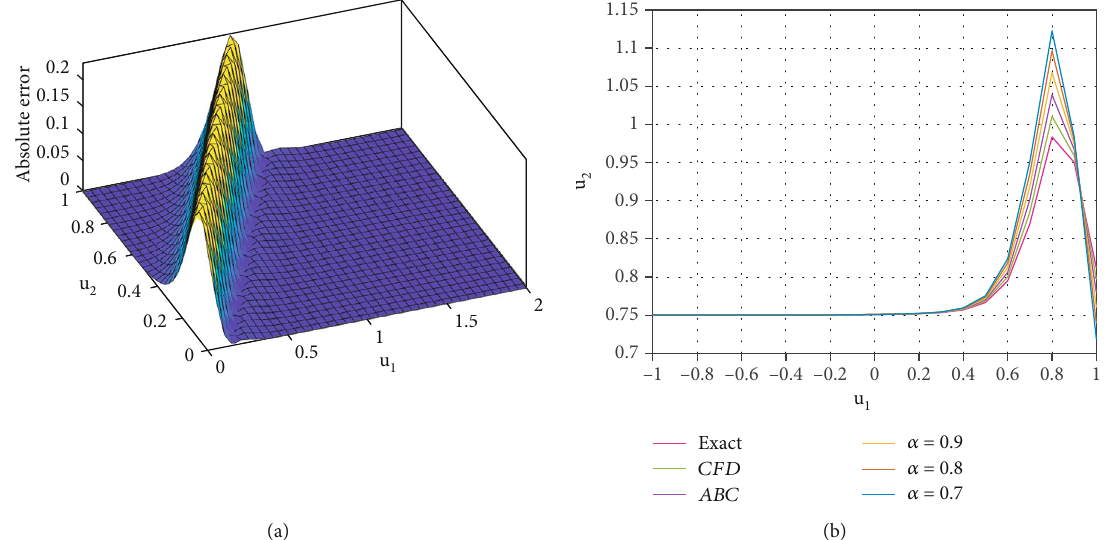
u t Þ . (b) 2D view of multiple fractional orders via JTDM of Example 16 for g ð u 1 , 2 ,